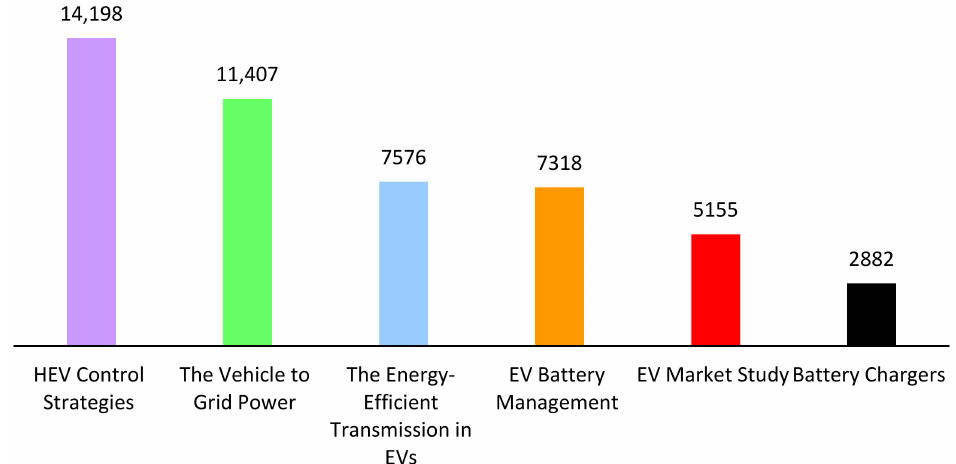
Figure 3. Representation of work distribution in each of the